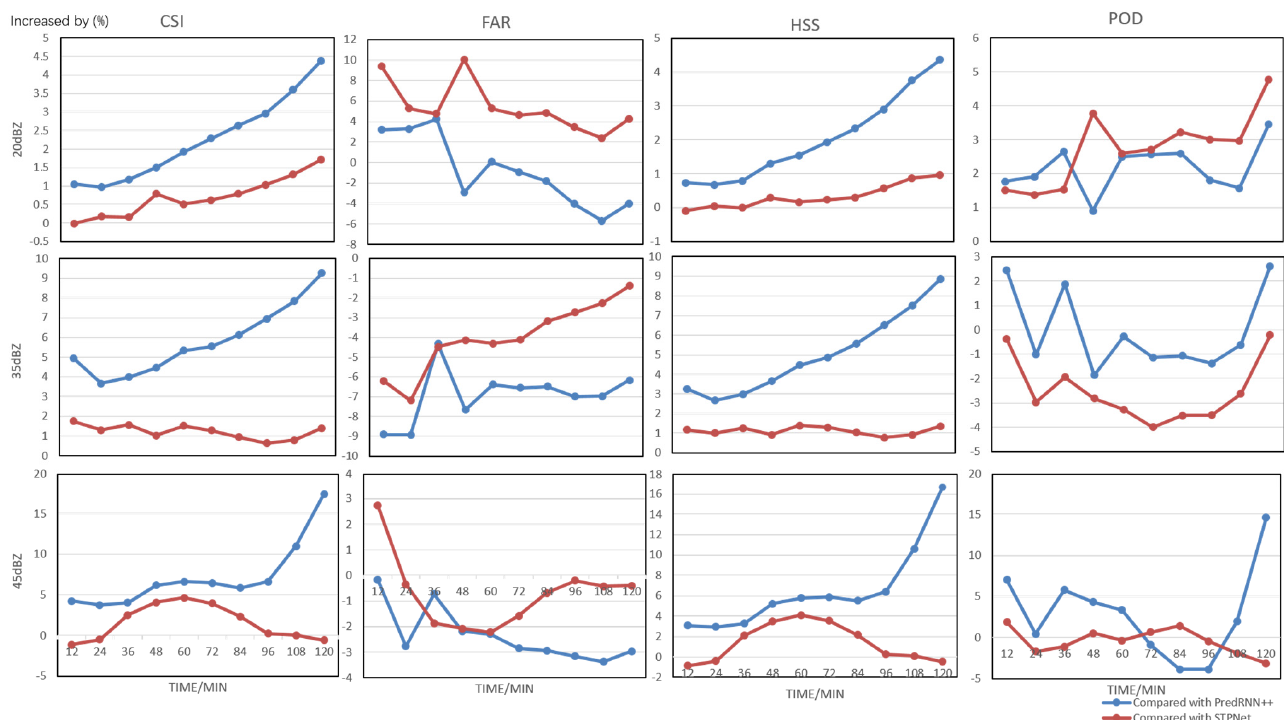
Figure 11. Nowcasting metric increasing rates compared with the STPNet and PredRNN++ methods for 12- to 120-min